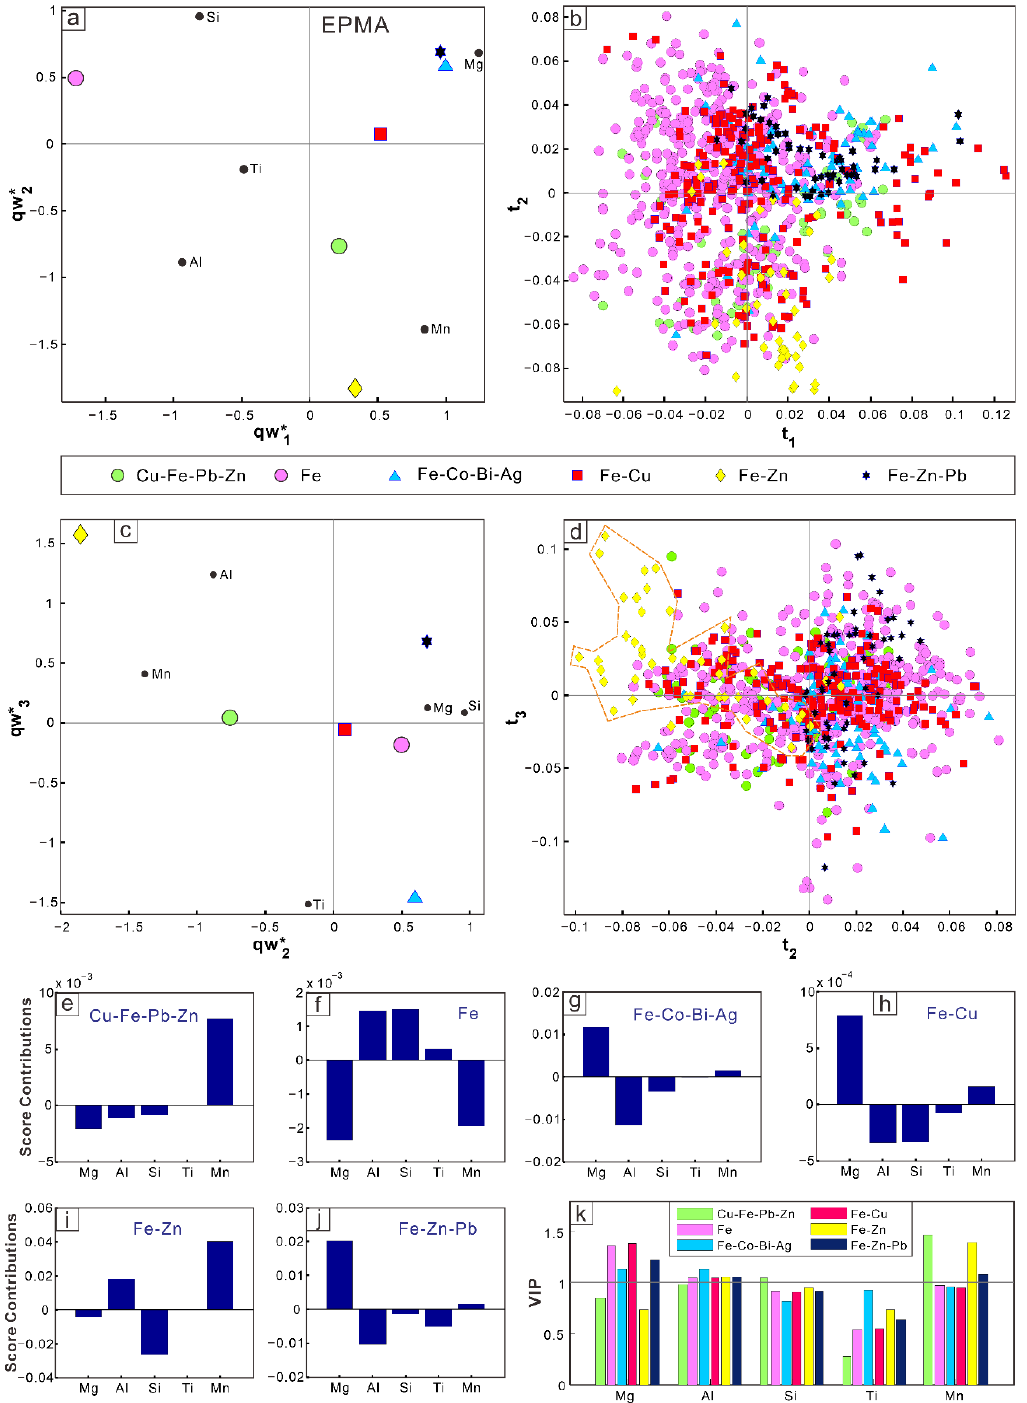
Figure 5. PLS-DA results of the EPMA data of magnetite. ( a ) The first and second loading plots show correlations among the element variables and mineralization types of skarn deposits. ( b ) The first and second score plots show the distribution of individual analyses of magnetite in the latent variable space defined by qw* 1 -qw* 2 in ( a ). ( c ) The second and third loading plots show correlations among the element variables and mineralization types. ( d ) The second and third score plots show the distribution of individual analyses of magnetite in the latent variable space defined by qw* 2 - qw* 3 in ( c ). ( e – j ) Score contribution plots for different mineralization types of skarn deposits. ( k ) Importance projection plot variance for the elements. The gray line marks the VIP value equal to 1.